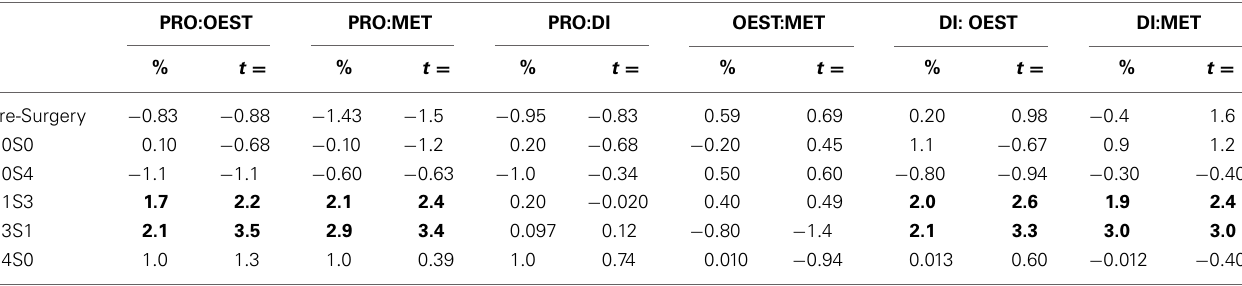
Table 7 | von Frey Test 3 examined the relationship between the response and the force of the von Frey filament, across a range of